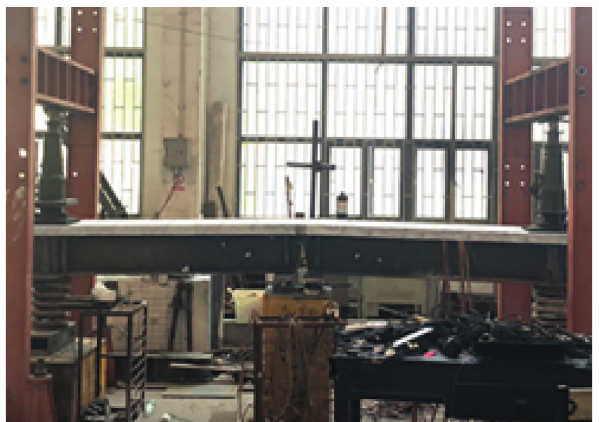
Figure 3: Rotation of the composite beam.